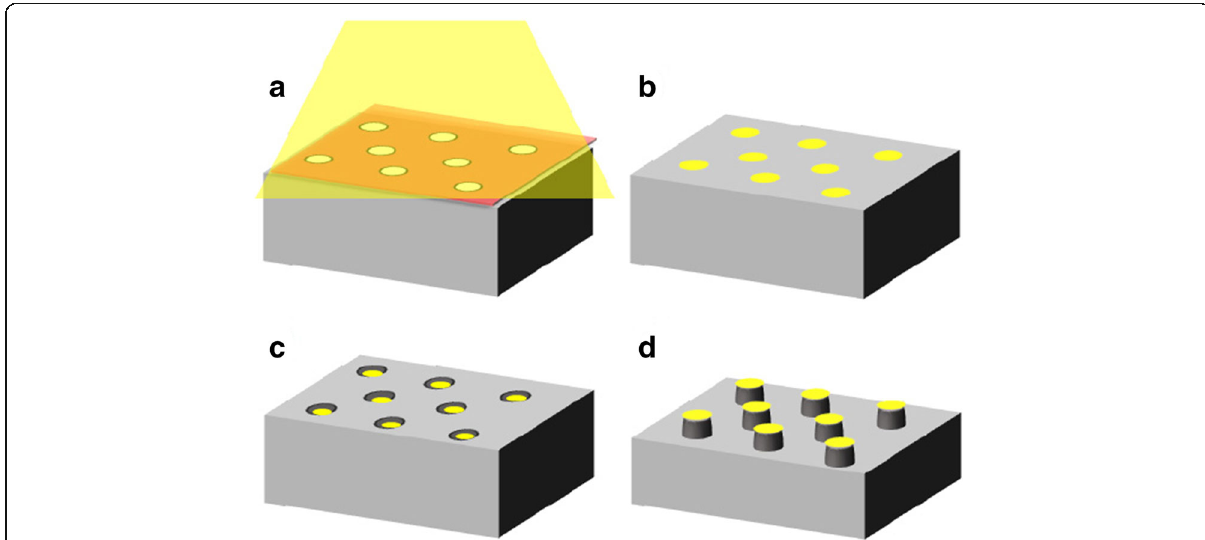
Fig. 1 Schematic model of the fabrication of GaAs nanopillar arrays. a Vacuum deposition of Au on a GaAs substrate through porous alumina mask. b Removal of the mask. c , d Chemical etching of GaAs using Au nanodot arrays as a